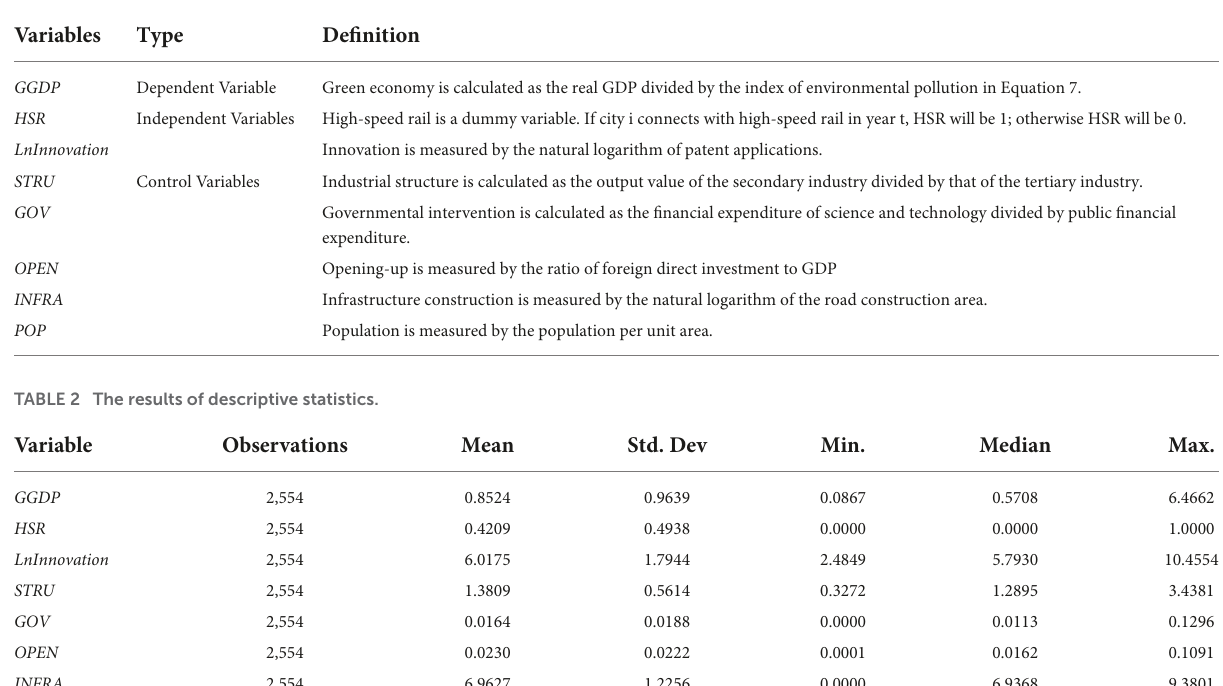
TABLE 1 The definitions of variables.